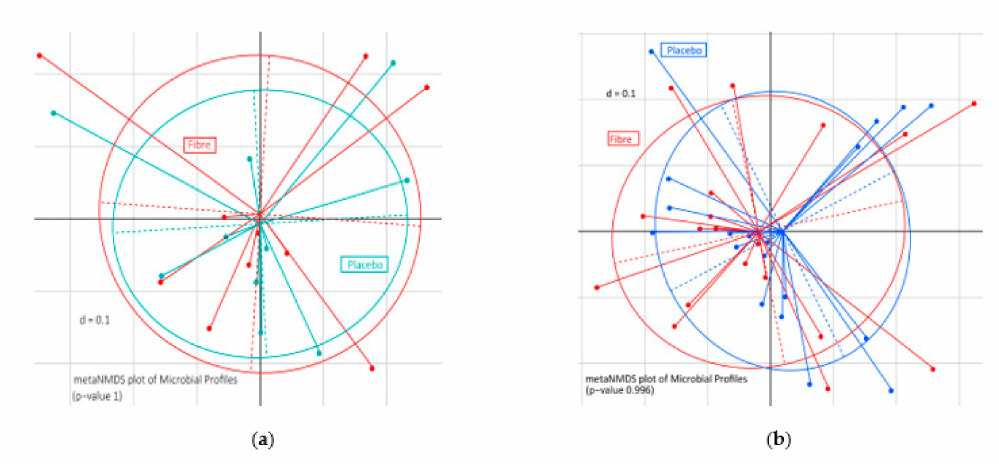
Figure 2. Fecal microbiota analysis by 16 S rRNA gene amplicon analysis. ( a ) Extrinsic wheat fiber-enriched foods, and ( b ) extrinsic wheat fiber-enriched drink. metaNMDS is meta non-parametric, multidimensional scaling plot of phylogenetic distances based on generalized UniFrac (beta-diversity).